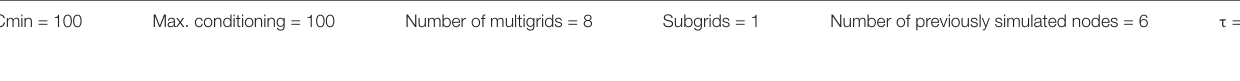
Frontiers in Earth Science |